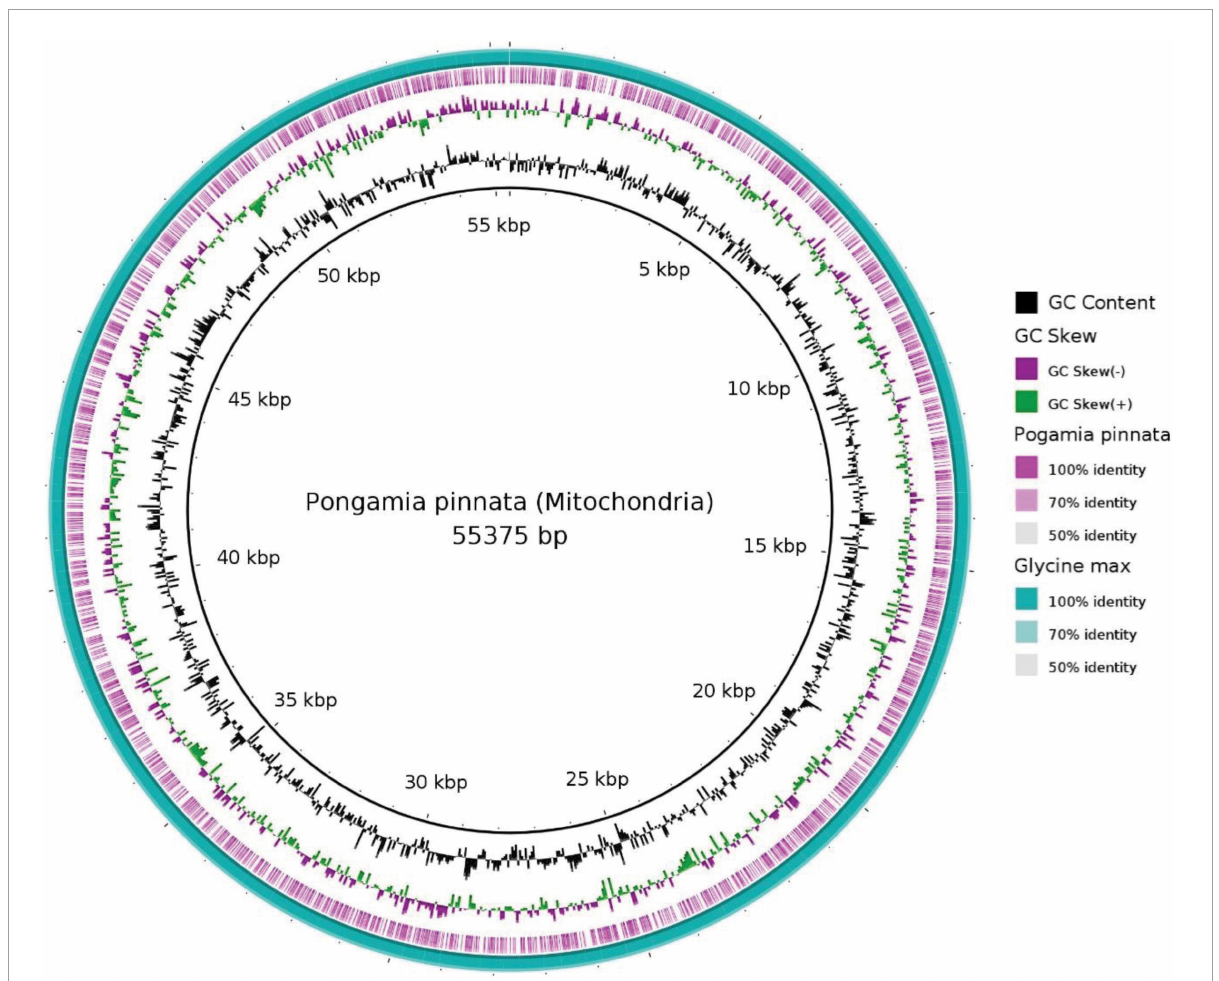
FIGURE4 Mitochondrial genome architecture of Pongamia pinnata with comparison to Glycine max . Moving from outside to inside, the first circle shows the blast alignment of the Glycine max , while the second purple ring represents blast alignment of the Pongamia pinnata . The third circle shows the GC Skew with above-zero values in green and below-zero values in purple. The fourth circle shows the mean centered GC content, with the average GC as the baseline and outward projections as higher than average and inwardly projections as lower than average. The inner circle shows the position coordinates for the mitochondrial genome